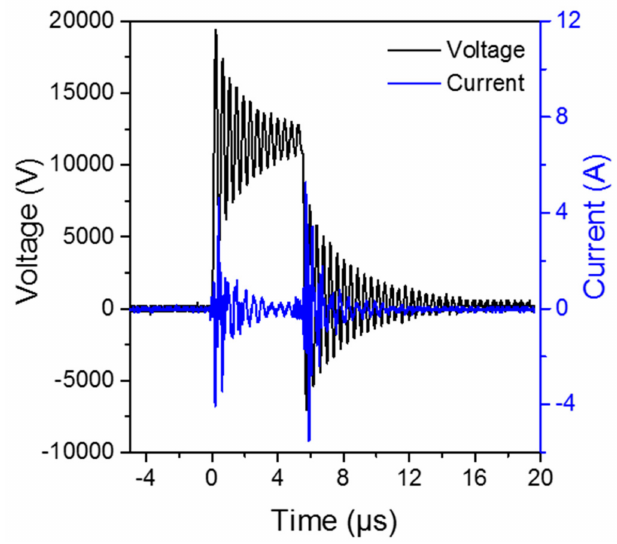
Figure 13. Voltage and current waveforms delivered to the DBD regeneration